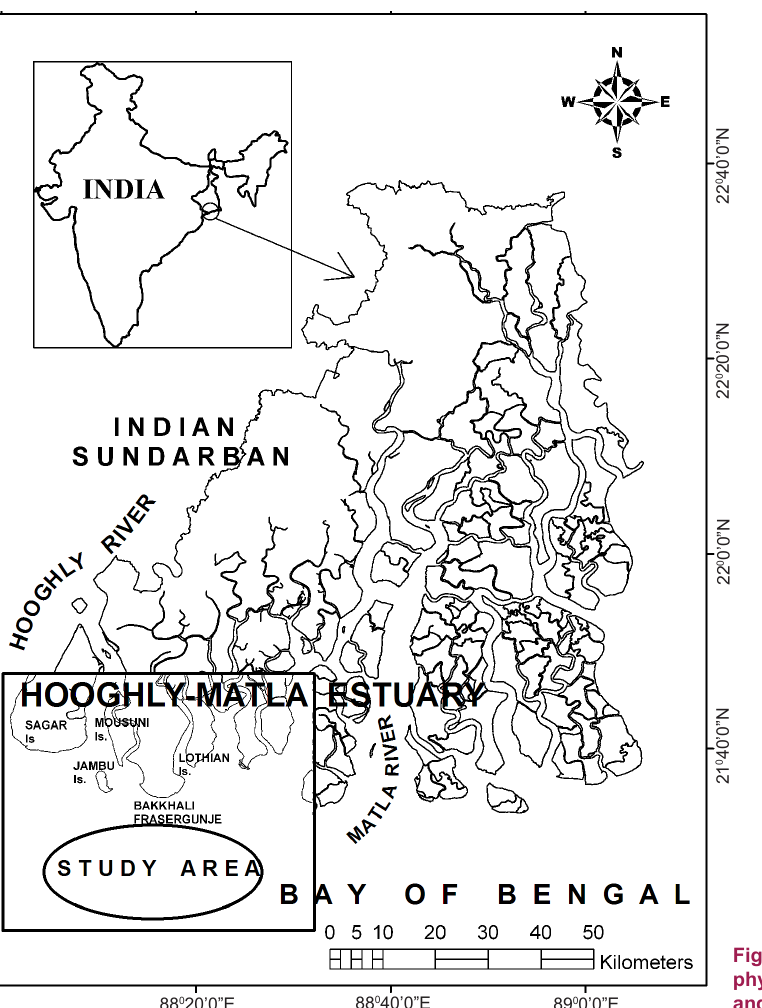
Figure 1. Sampling location of phytoplankton in the Hooghly-Matla estuary and offshore of Indian Sundarban. 88 0